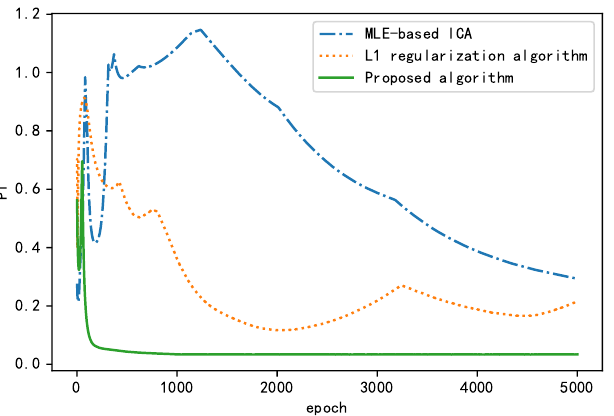
Figure 18. Performance comparison of different algorithms for sparse data